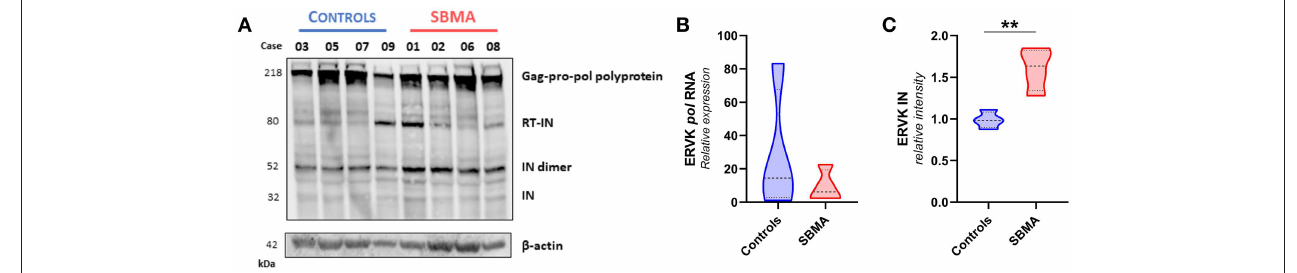
FIGURE 3 | Patients with SBMA exhibit increased levels of ERVK integrase protein. (A) Ex vivo PBMC from controls ( n = 4) and patients with SBMA ( n = 4) were evaluated for protein expression of ERVK integrase (IN) polyproteins and mature isoform. Notable cleavage of ERVK pol polyprotein into mature 32 kDa monomer and 52 kDa dimer integrase forms occurs to a greater extent in patients with SBMA than controls. SBMA patients had 60, 58, 52, and 55 CAG repeats in their androgen receptor gene respectively (left to right). Endogenous β -actin was used as a loading control. (B) Similar ERVK pol transcript expression in control and SBMA cases. (C) Relative quantification of ERVK IN dimers (52 kDa bands) revealed statistical differences in IN protein expression between controls and patients with SBMA, with p < 0.01 (**). Violin plots depict measured values from individual patients and the probability density of the grouped